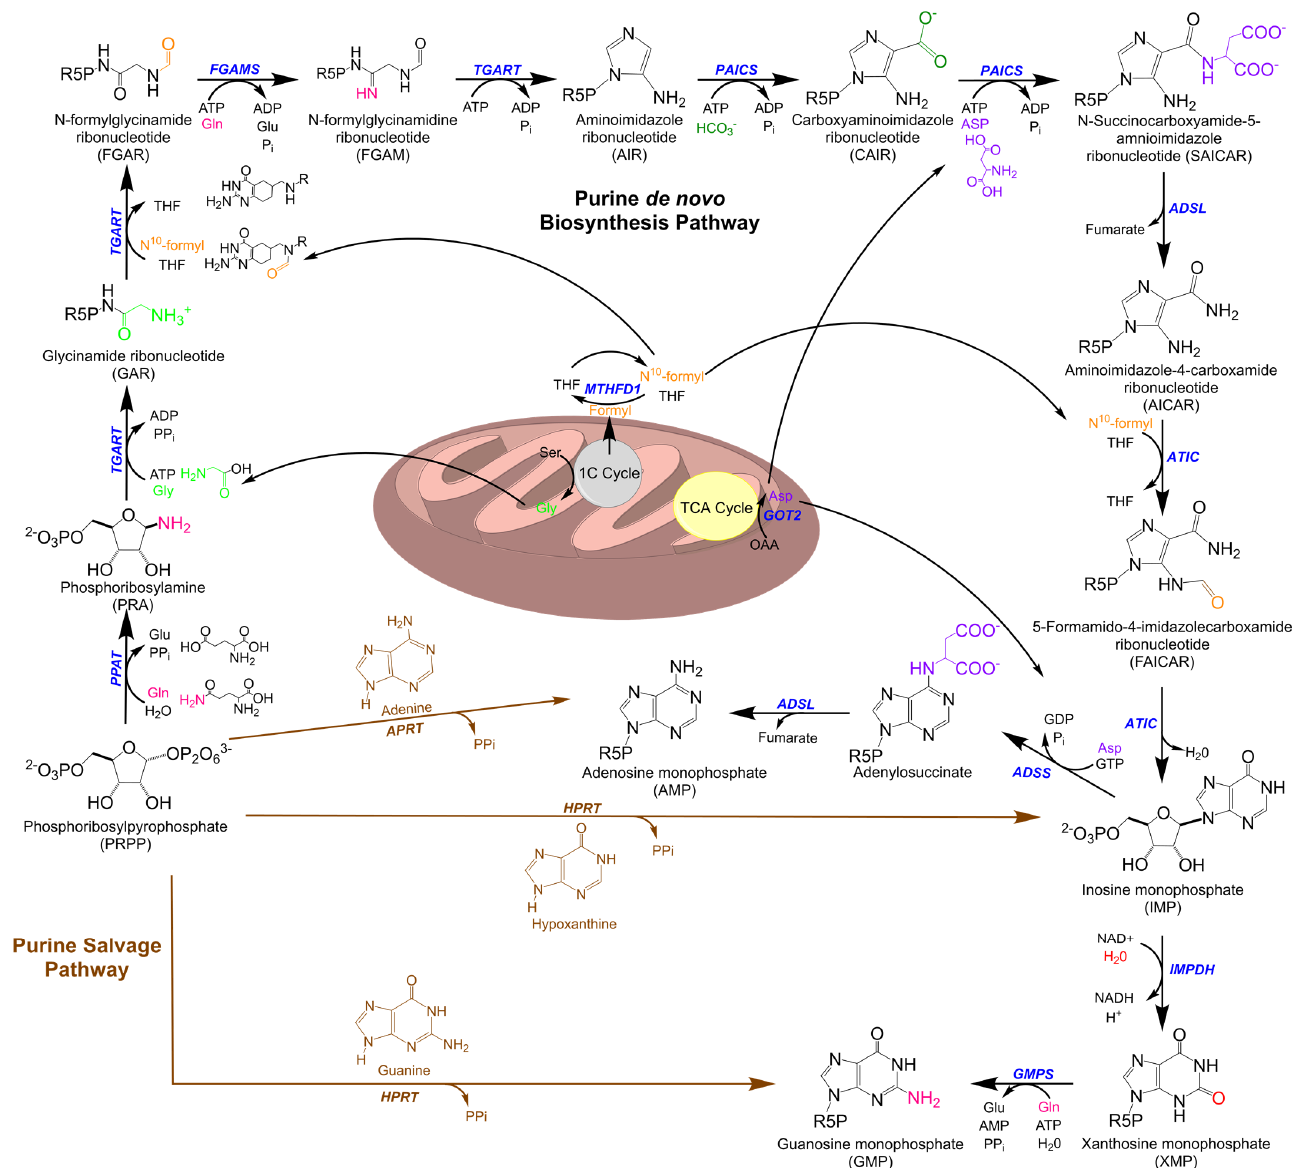
Figure 1. Purine metabolic pathways. The schematic representation shows the de novo and salvage pathways and their crosstalk with mitochondria. The conserved de novo biosynthesis pathway to generate IMP consists of 10 chemical steps catalyzed by 6 gene products in humans. These include the trifunctional enzyme TGART , composed of GAR synthetase (GARS), GAR transformylase (GARTfase), and AIR synthetase (AIRS) domains; the bifunctional enzymes PAICS , composed of CAIR synthetase/AIR carboxylase (CAIRS) and SAICAR synthetase (SAICARS), and ATIC , composed of AICAR transformylase (AICART) and IMP cyclohydrolase ( IMPCH ); and three monofunctional enzymes, phosphoribosyl amidotransferase ( PPAT ), formylglycinamidine ribonucleotide synthetase ( FGAMS ), and adenylosuccinate lyase ( ADSL ). Downstream IMP is converted to (1) GMP through stepwise reactions of IMP dehydrogenase ( IMPDH ) followed by GMP synthetase ( GMPS ) and (2) AMP via adenylosuccinate synthetase ( ADSS ) followed by ADSL . The salvage pathway requires PRPP to generate IMP and GMP through one-step reactions mediated by hypoxanthine phosphoribosyltransferase ( HPRT ) utilizing hypoxanthine and guanine bases. AMP is generated by adenine phosphoribosyltransferase ( APRT ) utilizing adenine base and PRPP as substrates. Mitochondria supply precursors for purine de novo biosynthesis including glycine, N 10 -formyl THF, and aspartic acid through their one-carbon cycle (1C cycle) and tricarboxylic acid cycle (TCA). Under high cellular purine demands exceeding the capacity of salvage, the nucleotide requirement is met by upregulation of the de novo biosynthetic pathway [4]. This is a highly conserved pathway that produces AMP and GMP using metabolic precursors